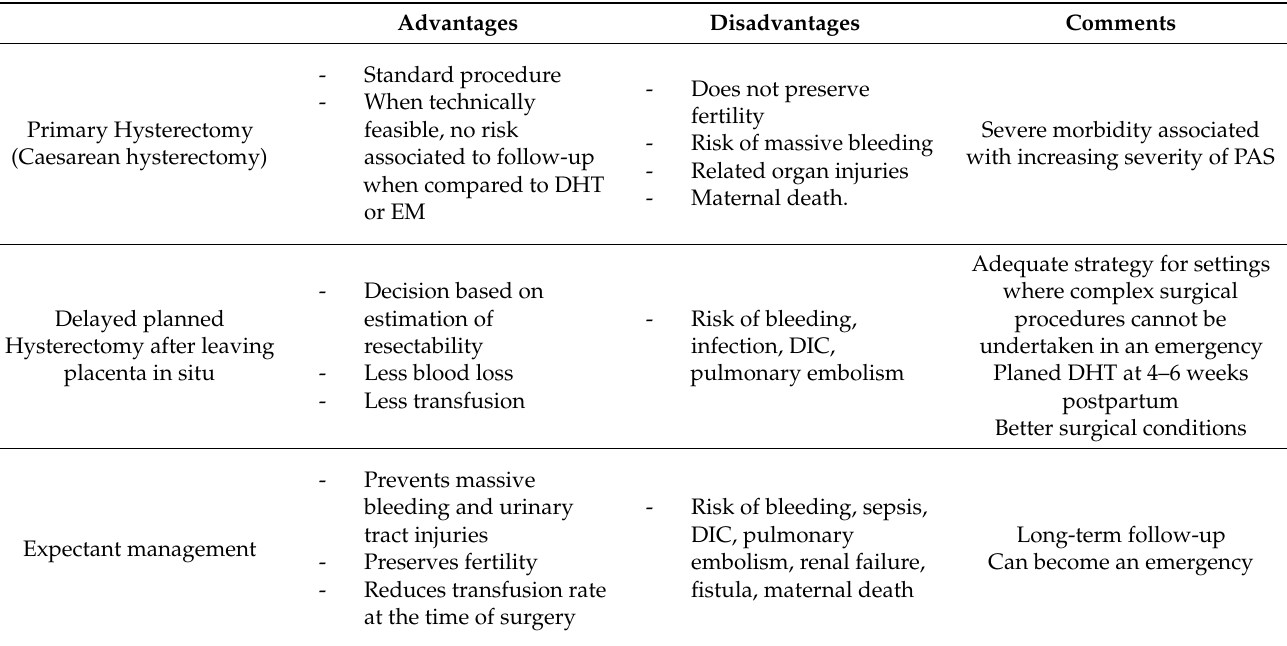
Table 2. Analysis of different management decisions in PAS